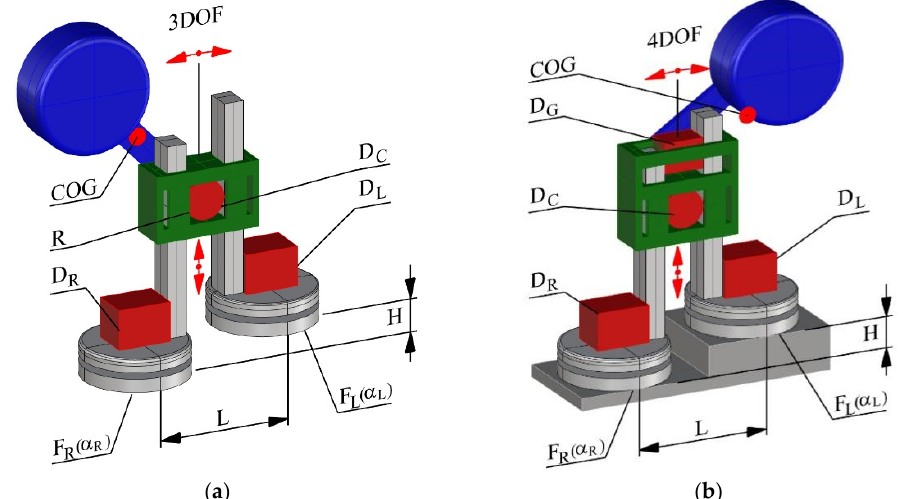
Figure 1. An innovative bipedal robot with swivel feet: D R , D L —drives of feet, F R , F L —swivel feet of robo, D C —drive of robots leg, COG—centre of gravity, L—distance between feet axis, H—vertical move of feet: ( a ) 3DOF robot balancing mass moved using D C drive; ( b ) 4DOF robot balancing mass moving using D G —independent balancing drive .